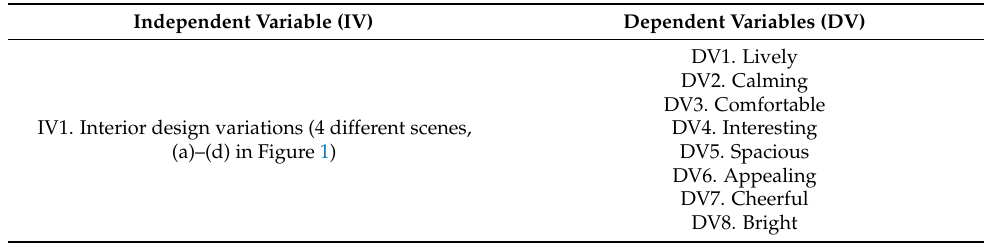
Table 1. Overview of the independent variable and dependent variables.